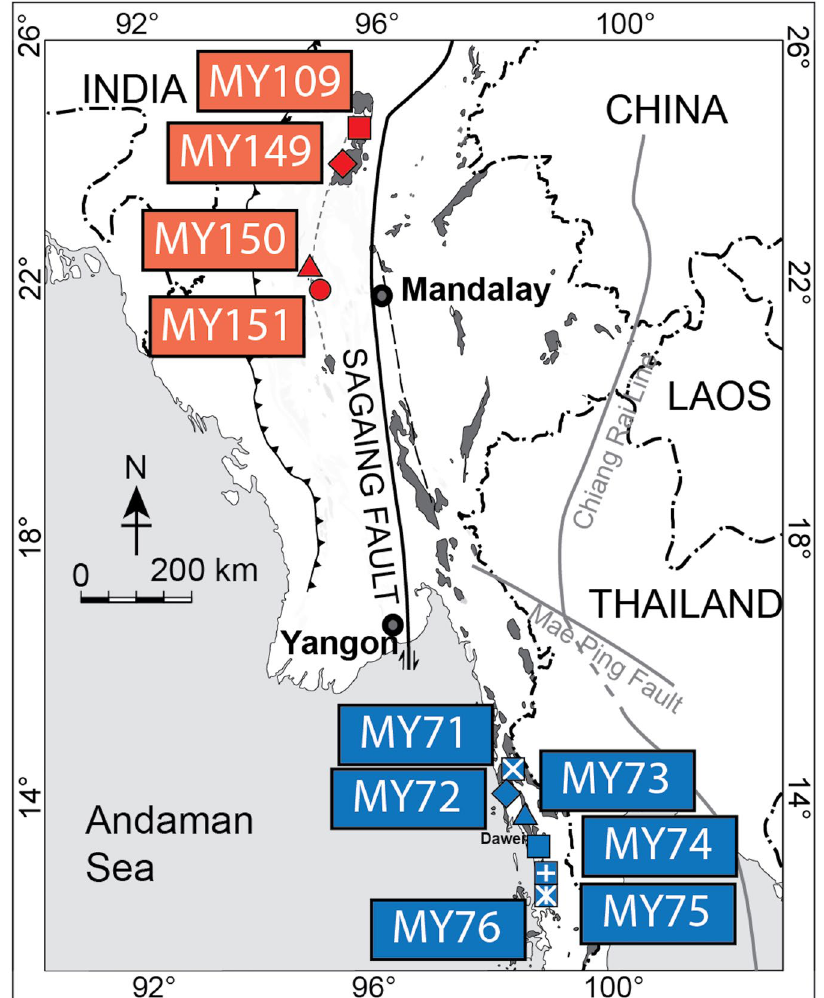
Figure 1. Outline map of Myanmar with sample localities of the tin belt (blue) and copper belt (red). The original juxtaposition of the two belts has been offset by dextral movement on the north-trending Sagaing Fault. Map made with Natural Earth Data